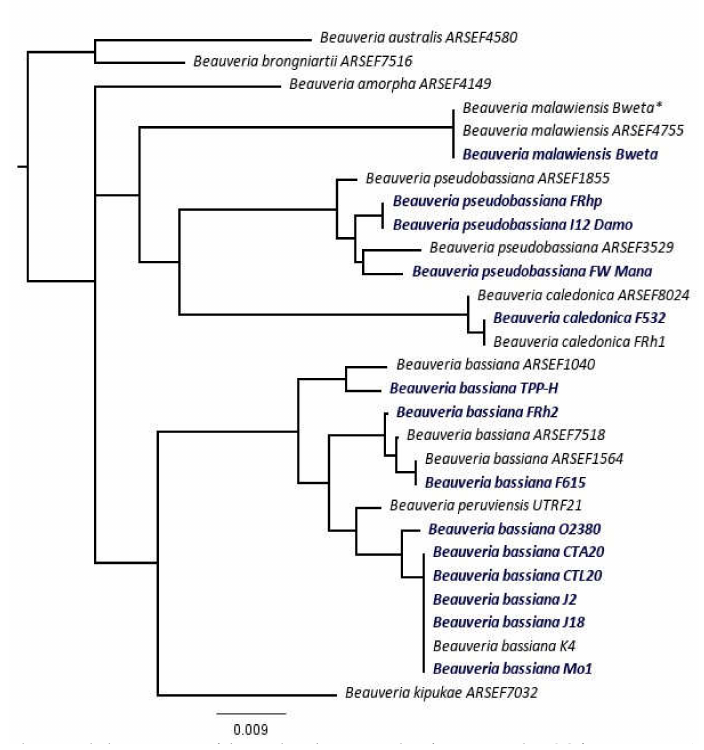
Figure 1. Phylogenetic tree of the combined-sequence data for EF1- α and BLOC from 14 Beauveria isolates derived from New Zealand collections (in bold) and 15 reference isolates based on the Neighbor-Joining method using Juke–Cantor distance model, with no outgroup and 1000 replicates of Bootstrapping. A support threshold of 50% was set in Geneious tree builder. Isolate Bweta appears twice in the figure, once as a reference isolate (Bweta*) and once for phylogenetic analysis using EF1- α + BLOC (bold).